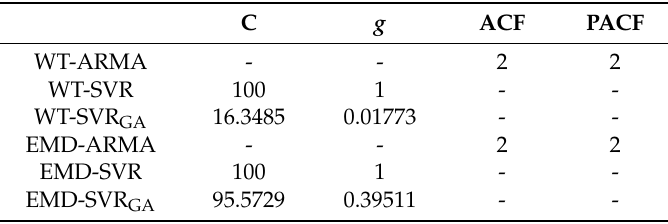
Table 4. Parameter values of the model. ACF is Autocorrelation coefficient, PACF is Partial autocorrelation